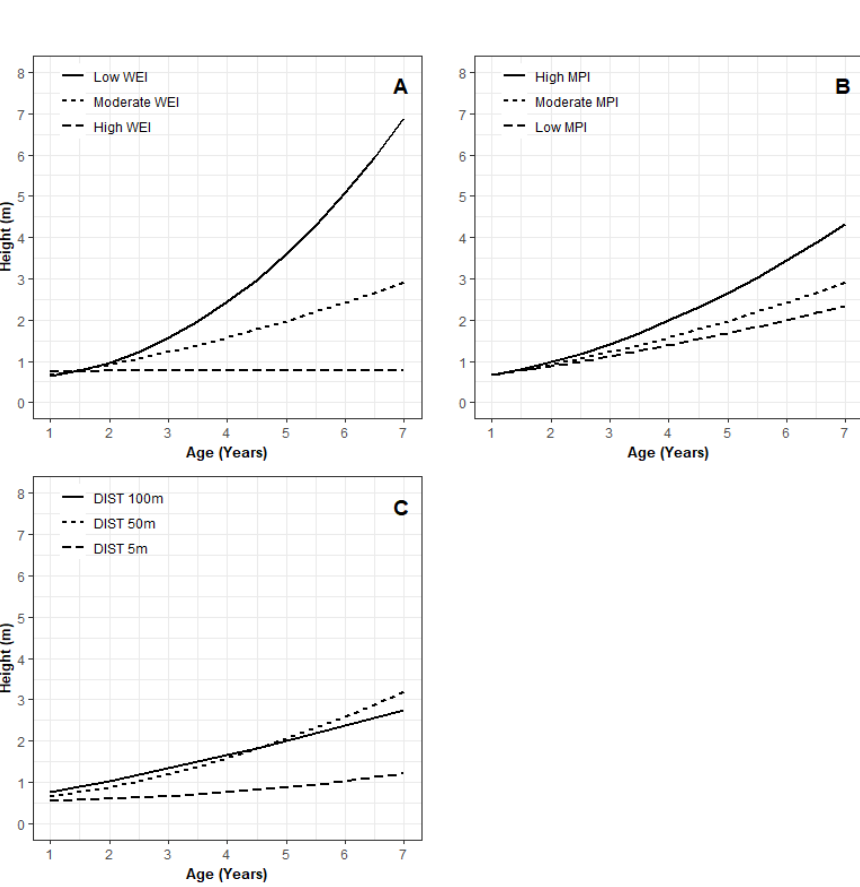
Figure 3. Micro-topographic effect on height growth of E. globoidea . ( A ) Effect of wind exposure index, ( B ) effect of morphometric protection index, and ( C ) effect of distance from the top ridge.